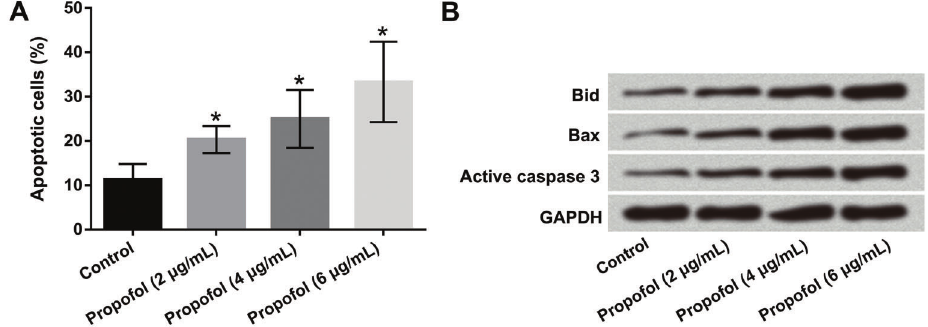
Figure 2. Propofol promoted cell apoptosis in Ishikawa cells. Human EC Ishikawa cell line was exposed to different concentrations of propofol (2, 4, and 6 m g/mL). After treatment for 24 h ( A ) the percentage of apoptotic cells and ( B ) the protein levels of Bid, Bax and